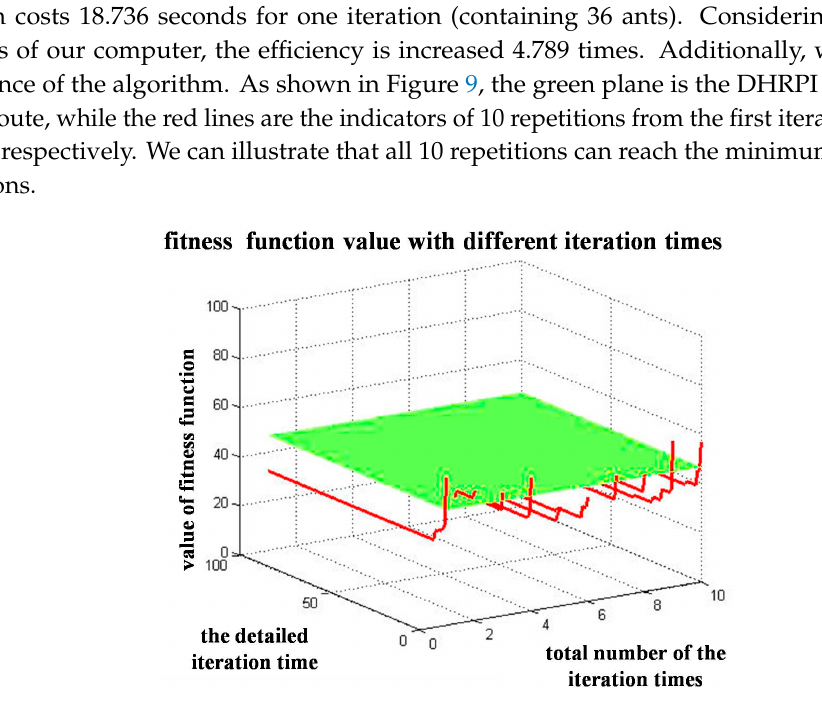
Figure 9. The cost function value variation from thefirst iteration to the 100 th iteration for the 10 repetitions.